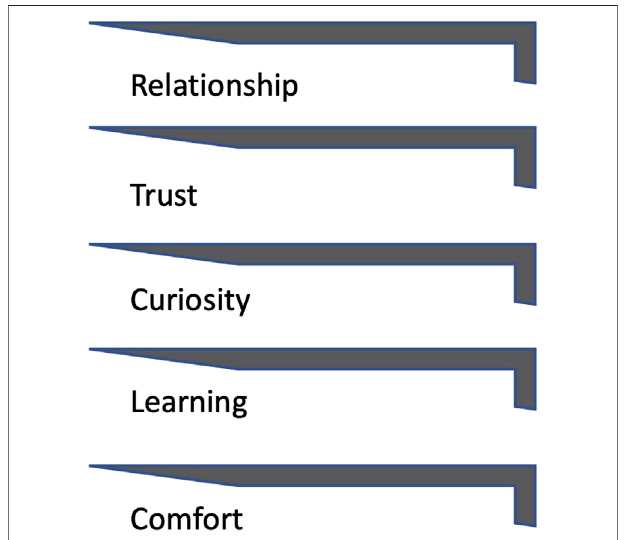
FIGURE 3 | Hierarchy model of youth leaders testing for trust.